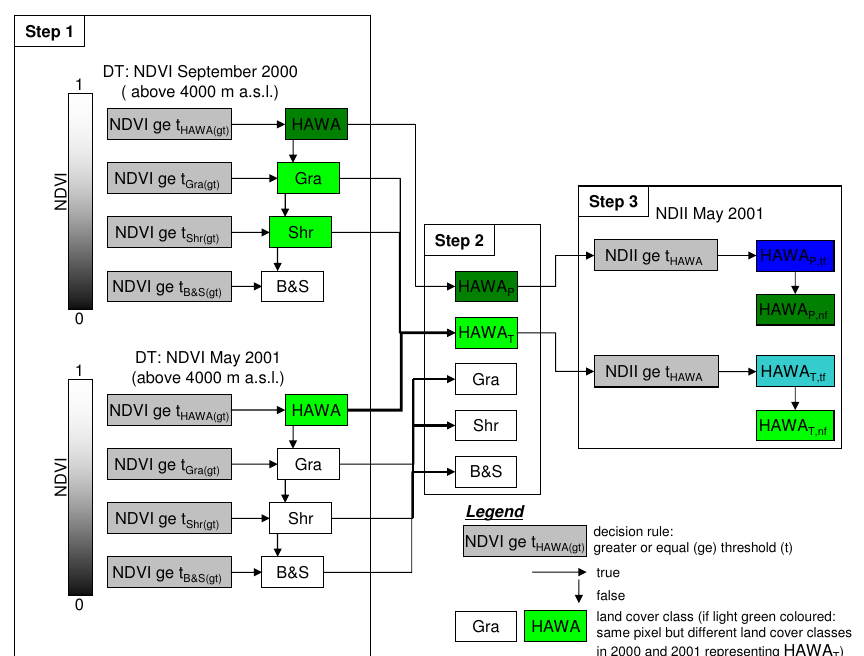
Fig. A1. HAWA mapping procedure: translation of the HAWA mapping design into a decision tree (DT) classifier for the use of remote- sensing